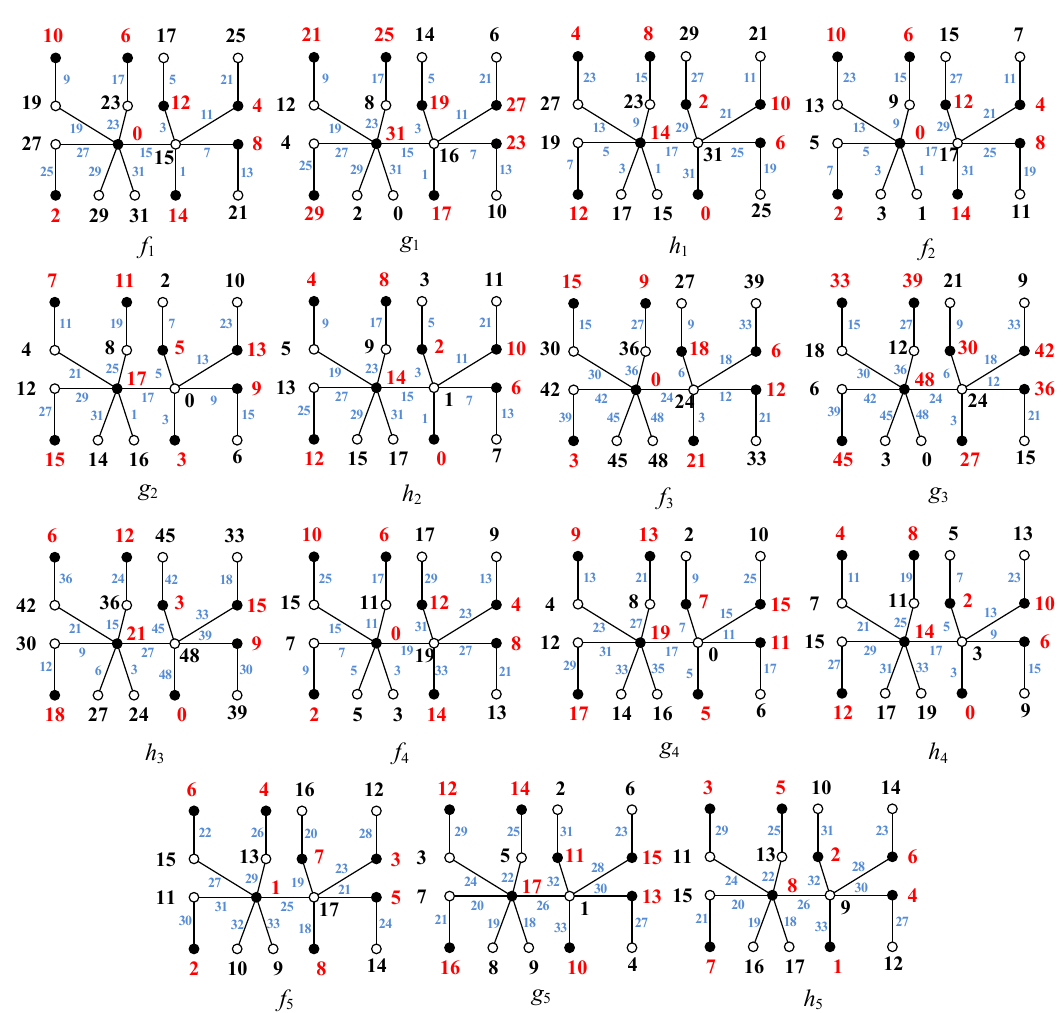
Figure 3. The examples for illustrating the conversions between image-labelings f s , f s , h s with s = 1,2,3,4,5 in the proofs of Theorem